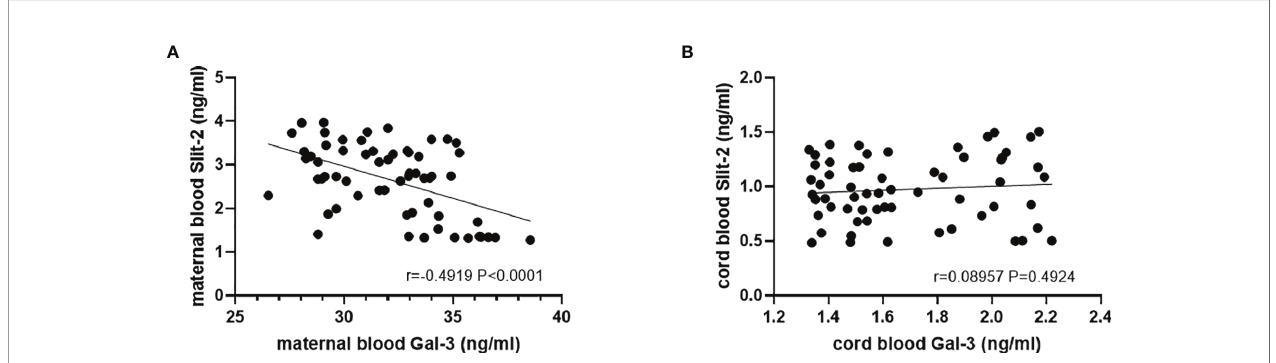
FIGURE 4 | Correlation between the Slit-2 level and Gal-3 level in maternal peripheral blood and neonatal cord blood of the patients with GDM. (A) Correlation between the Slit-2 level and Gal-3 level in maternal peripheral blood of the patients with GDM. (B) Correlation between the Slit-2 level and Gal-3 level in neonatal cord blood of the patients with GDM. Slit-2 (Slit guidance ligand 2); Gal-3 (Galectin 3).